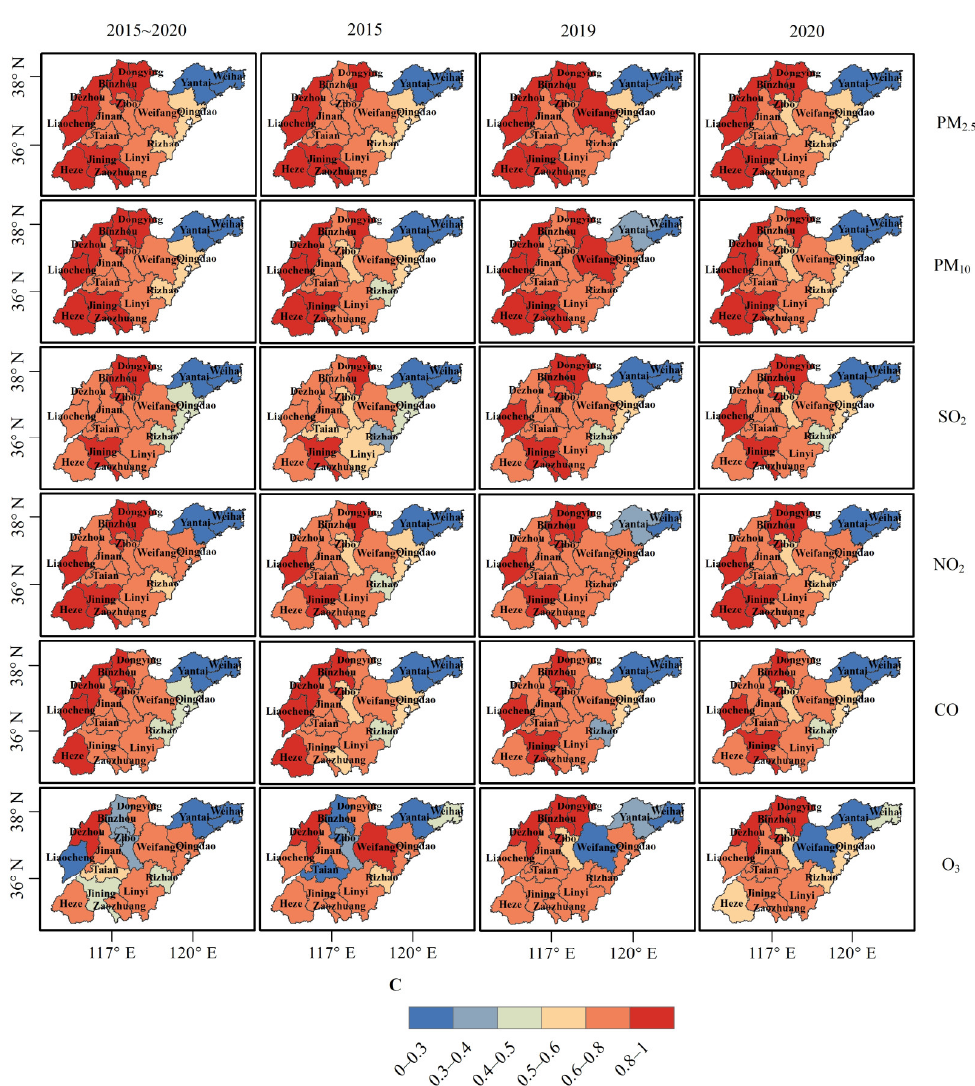
Figure 8. Distribution of coupling coordination degree between Annual average AOD and each pol- lution indicator in prefecture level cities in Shandong Province in 2015–2020, 2015, 2019, and